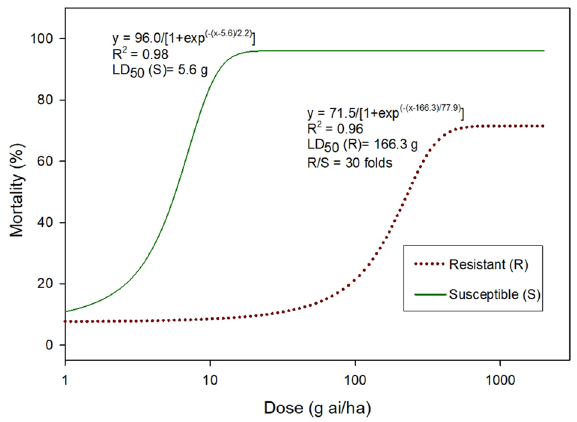
Figure 2. Dose–response for the ALS-inhibitor nicosulfuron (Accent Q) herbicide resistant (pollen donor) and susceptible (pollen receptor) johnsongrass plants used in the study. The susceptible plants were sprayed at seven doses (0, 0.0625, 0.125, 0.25, 0.5, 1, and 2×) and the resistant plants were sprayed at nine doses (0, 0.25, 0.5, 1, 2, 4, 8, 16, and 32×) (1× = 63.05 g ai/ha). Plant survival was evaluated at 28 days after herbicide application. In the equation, y = mortality (%), x = herbicide dose (g ai/ha); LD 50 = amount of herbicide that killed 50% of the test plants; R/S = LD 50 of R biotype/LD 50 of S